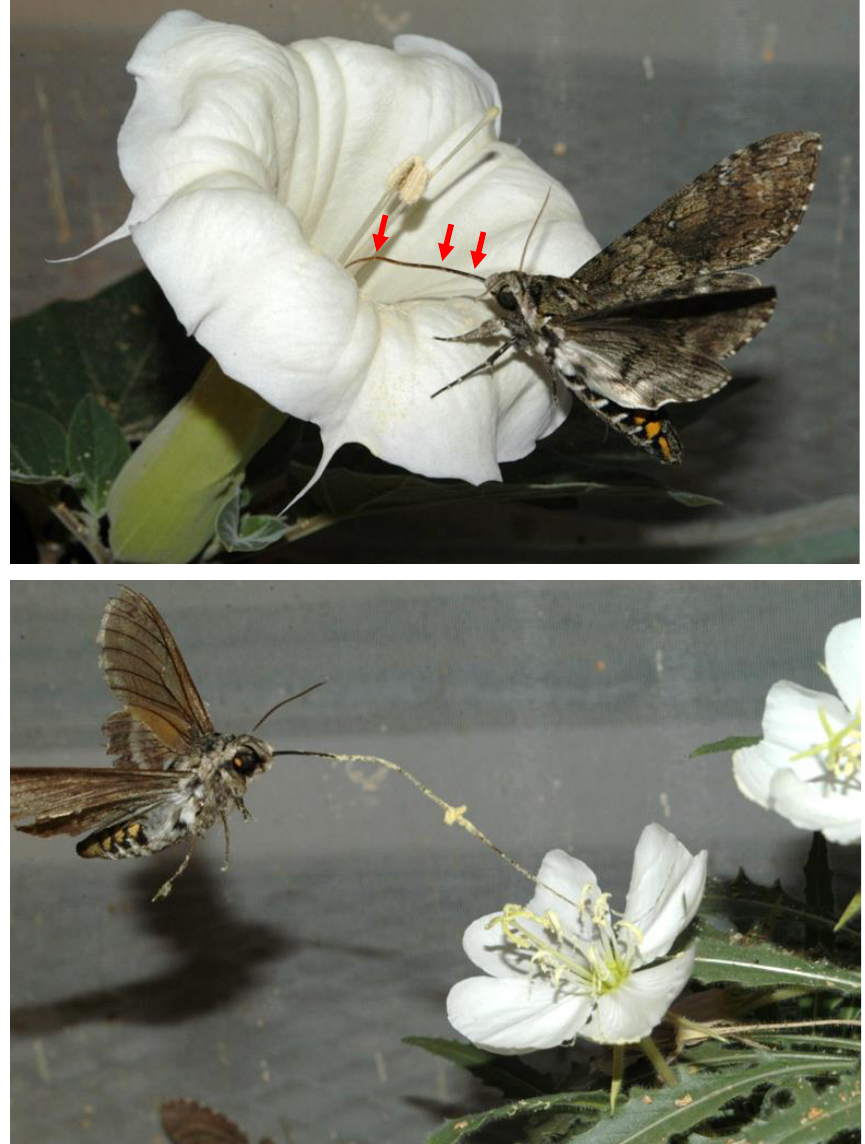
Figure 1. Pollen being deposited on the proboscises of Manduca sexta while visiting Datura wrightii (top) and Oenothera harringtonii (bottom). While the yellow pollen of O. harringtonii is especially obvious, pollen can be seen on the proboscis of both moth individuals with the naked eye (highlighted with arrows on the moth visiting D. wrightii ). Manduca sexta proboscises contact Datura wrightii anthers and stigmas as they approach and probe the